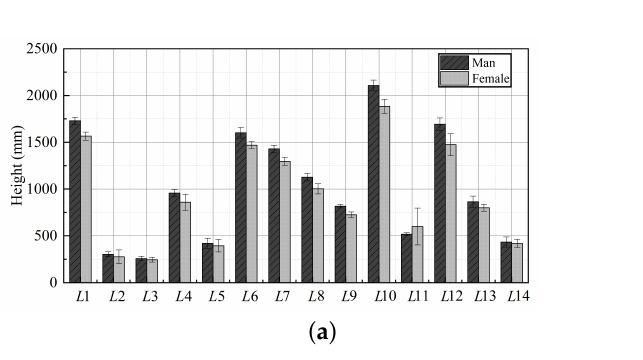
Figure 5. Anthropometric data results. Two-dimensional body data were collected from elderly subjects according to anthropometric standards. ( a ) Mean standing posture measurement site results. ( b ) Mean sitting posture measurement site